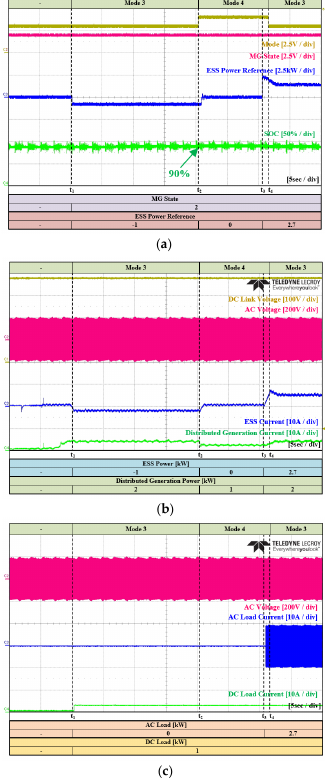
Figure 24. Experimental waveforms of standalone Modes 3 and 4. ( a ) Waveforms of the input data (MG state, SOC) and output data (Mode, ESS power reference) of the ANN. ( b ) Waveforms of DC link and AC voltage, ESS, and DG current. ( c ) Waveforms of each load current and AC grid volt- age. Table 6. Microgrid power flow (2) during standalone operation.